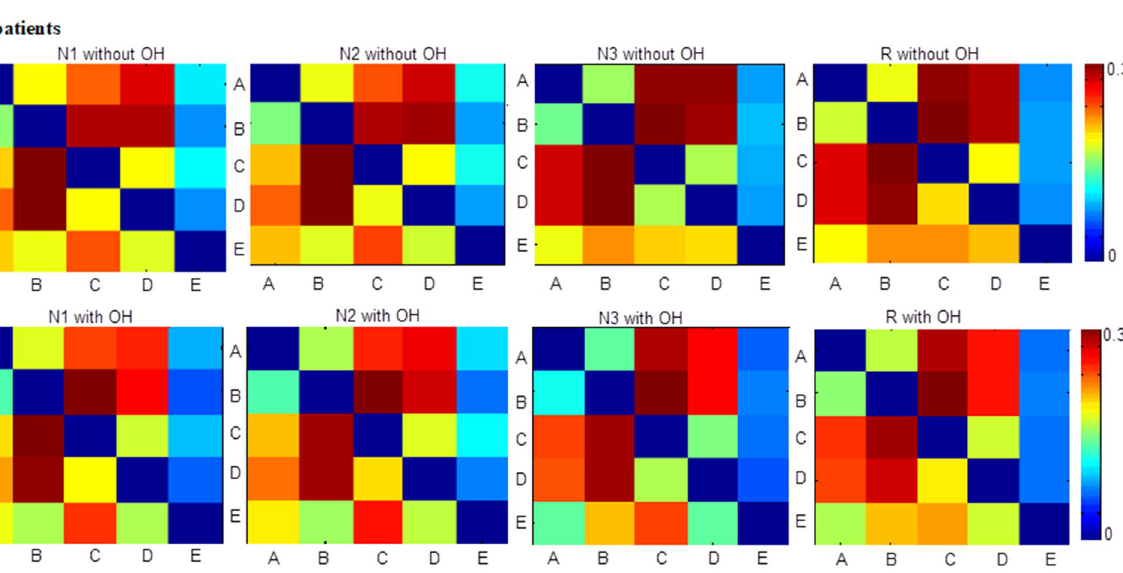
Figure 3. Transition probabilities (TP) of 5 microstates in OSA_OH and OSA_withoutOH The sample entropy of OSA_OH vs. control showed significant difference only in N1 (P = 0.015), while FDA showed significant difference in N1, N2, N3, R (P = 0.005; P = 0.001; P = 0.005; P = 0.005). The sample entropy of OSA_OH vs. OSA_withoutOH showed significant difference only in N1, N2 (P = 0.043; P = 0.042), and there was no significant difference in FDA. Correlation between microstate parameters and power, sample entropy and DFA. The cor- relation between the parameters of 4 and 5 microstates and power, sample entropy and DFA in OSA_OH and OSA_withoutOH patients was respectively compared, as shown in Tables 6 and 7. In Table 6, OSA_ withoutOH had no correlation in the four sleep stages, while OSA_OH had correlation only in N1, and only the parameters of microstate D was correlated with delta, alpha and beta power. They were positively correlated with delta power (r = 0.380, P = 0.007), and negatively correlated with alpha and beta power (r = − 0.362, P = 0.001; R = − 0.382, P = 0.006), and the TP B → C was positively correlated with alpha power (r = 0.388, P = 0.005). In Table 7, only parameters of microstate D in OSA_OH were correlated with delta and alpha power in N1, and the TP B → C and TP E → C was positively correlated with alpha power. The TP A → B and TP A → E were related to FDA in N2; TP A → E were related to FDA in N3; TP C → E were related to FDA in R. The five microstate parameters in OSA_withoutOH patients were all not correlated in four sleep stages, but various transition probabilities (TP X → Y )